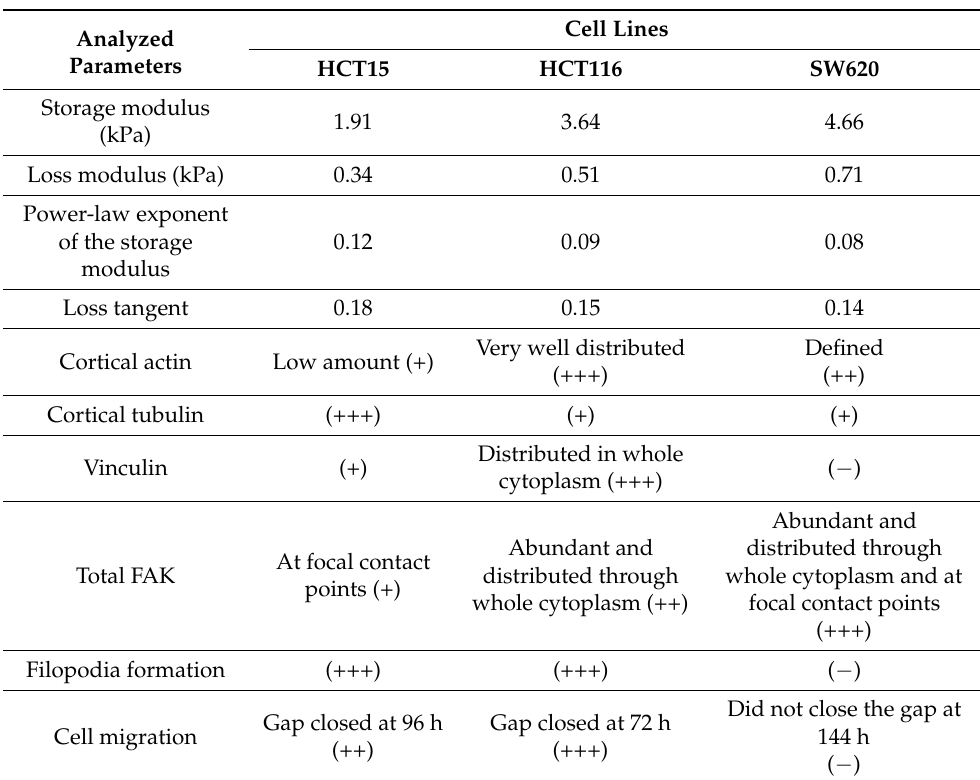
Table 3. Summary of results obtained from AFM, CLSM, and cell-migration assays of the three CRC cell